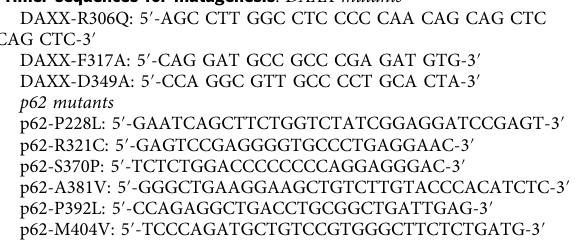
Primer sequences for mutagenesis . DAXX mutants DAXX-R306Q: 5 ′ -AGC CTT GGC CTC CCC CAA CAG CAG CTC CAG CTC-3 ′ DAXX-F317A: 5 ′ -CAG GAT GCC GCC CGA GAT GTG-3 ′ DAXX-D349A: 5 ′ -CCA GGC GTT GCC CCT GCA CTA-3 ′ p62 mutants p62-P228L: 5 ′ -GAATCAGCTTCTGGTCTATCGGAGGATCCGAGT-3 ′ p62-R321C: 5 ′ -GAGTCCGAGGGGTGCCCTGAGGAAC-3 ′ p62-S370P: 5 ′ -TCTCTGGACCCCCCCCAGGAGGGAC-3 ′ p62-A381V: 5 ′ -GGGCTGAAGGAAGCTGTCTTGTACCCACATCTC-3 ′ p62-P392L: 5 ′ -CCAGAGGCTGACCTGCGGCTGATTGAG-3 ′ p62-M404V: 5 ′ -TCCCAGATGCTGTCCGTGGGCTTCTCTGATG-3 ′